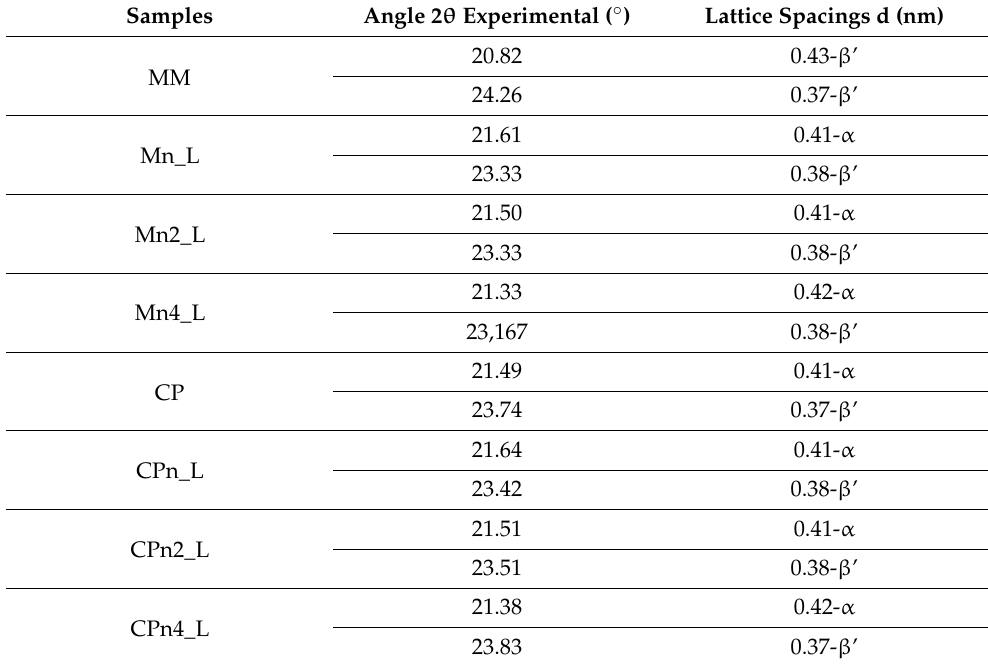
Table 2. Main reflections and lattice spacings of the CP, MM, and hybrid nanoparticles calculated by Bragg equation. Note: α is considered the most unstable form, d values between 0.415 and 0.42 nm, β stable forms, d = 0.46 nm and β ’ with 0.42 < d < 0.43 nm or 0.37 < d < 0.40 nm. Samples Angle 2 θ Experimental ( ◦ ) Lattice Spacings d